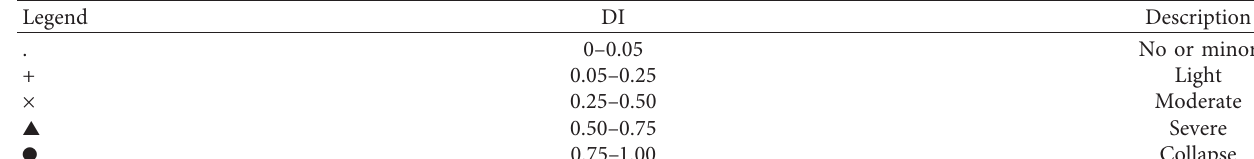
Table 5: Cao et al. [96] damage levels and the